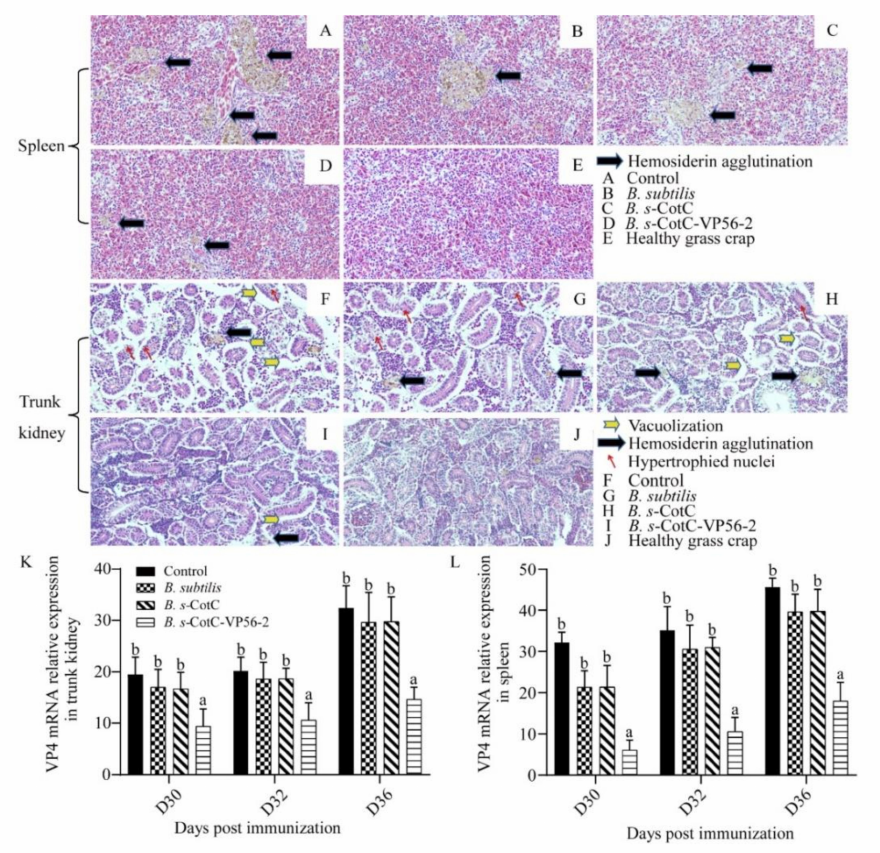
Figure 7. Tissue damage and viral loads in spleen and trunk kidney after challenge. On day 0, grass carp were fed with ordinary feed, B. subtilis feed, B. s -CotC mixed feed and B. s -CotC-VP56-2 feed. GCRV-II was injected intraperitoneally on 29 dpi. Spleen and trunk kidney tissues were collected on 36 dpi, sectioned and stained with HE. Healthy grass carp tissue was used as a blank control. In the spleen, vacuolation and nuclear cysts are the two main signs ( A – E ). The main manifestations in the trunk kidney are the formation of vacuoles, the agglutination of hemosiderin and the hypertrophy of the nucleus ( F – J ). mRNA expression profile of GCRV-II in trunk kidney ( K ) and spleen ( L ). We used the qRT-PCR method to detect and 18S rRNA as an internal reference gene. Different superscript letters in each group (a,b) denote significant variations suggested by the Kruskal–Wallis